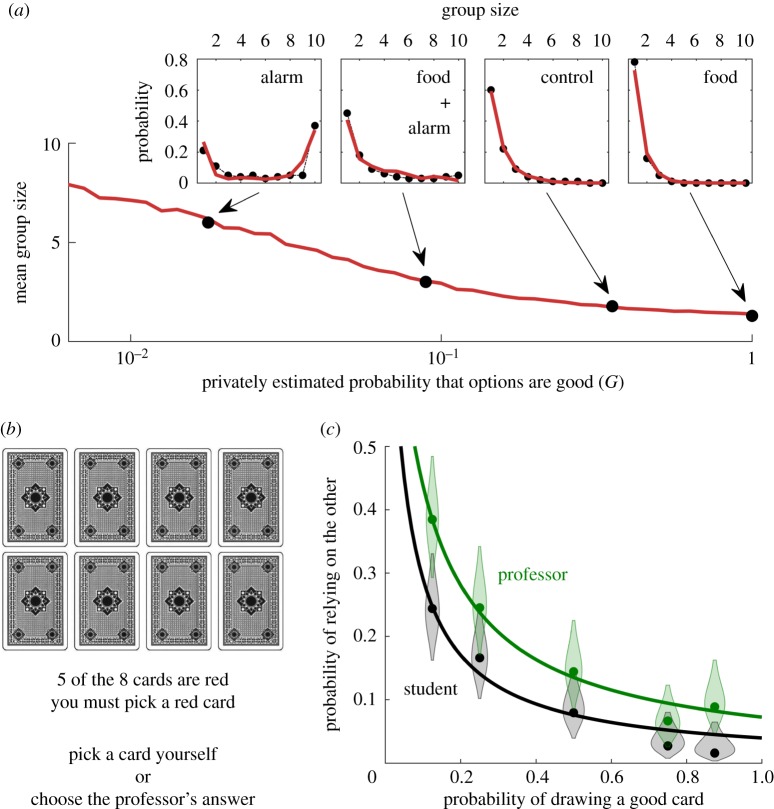
Experiments are consistent with super-aggregation in adversity emerging from decision-making. (a) Mean group size for 10 fish swimming in a closed space as a function of the privately estimated quality, as predicted by the spatial model. The black dots indicate the experimental mean group sizes [7], and the values of G that best fit the experiments. Insets: distributions of group sizes for the four experiments (dots: experimental data. red line: simulations). (b) Layout of the experiment of Case et al. [49]. (c) Probability of relying on the card choice of another person (a professor for the green data and a student for the black data), as a function of the proportion of red cards (which is equivalent to the probability of getting a good card at random). Dots: experimental data (curved patches indicate experimental uncertainty due to sampling, with width proportional to the probability that the true value falls at each value, and truncated at the 95% CI). Lines: model (equation (4.24)).